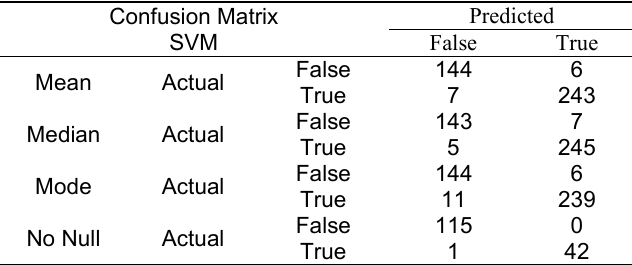
Table 6. Confusion Matrix for Support Vector Machine